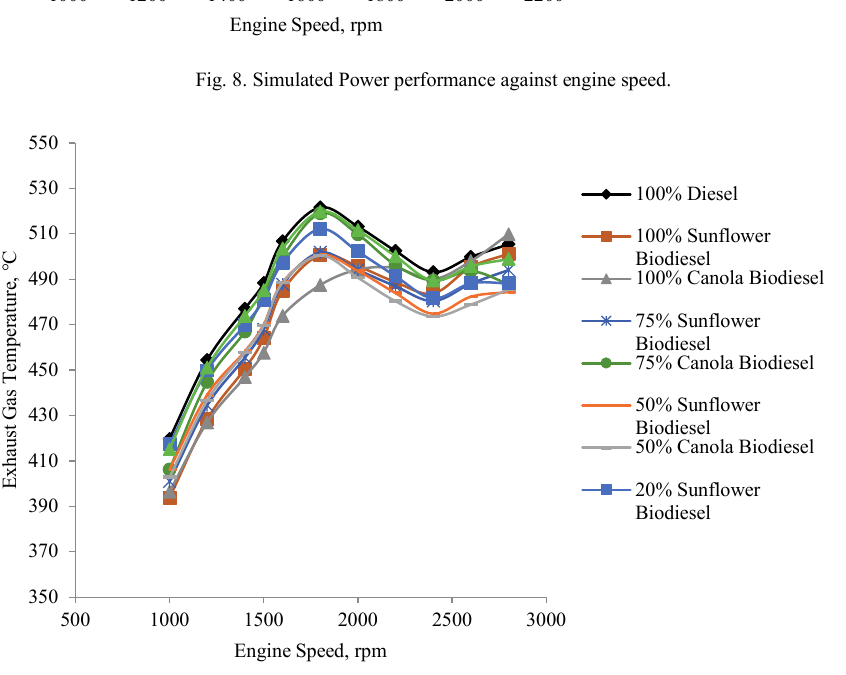
Fig. 9. Exhaust gas temperature against engine